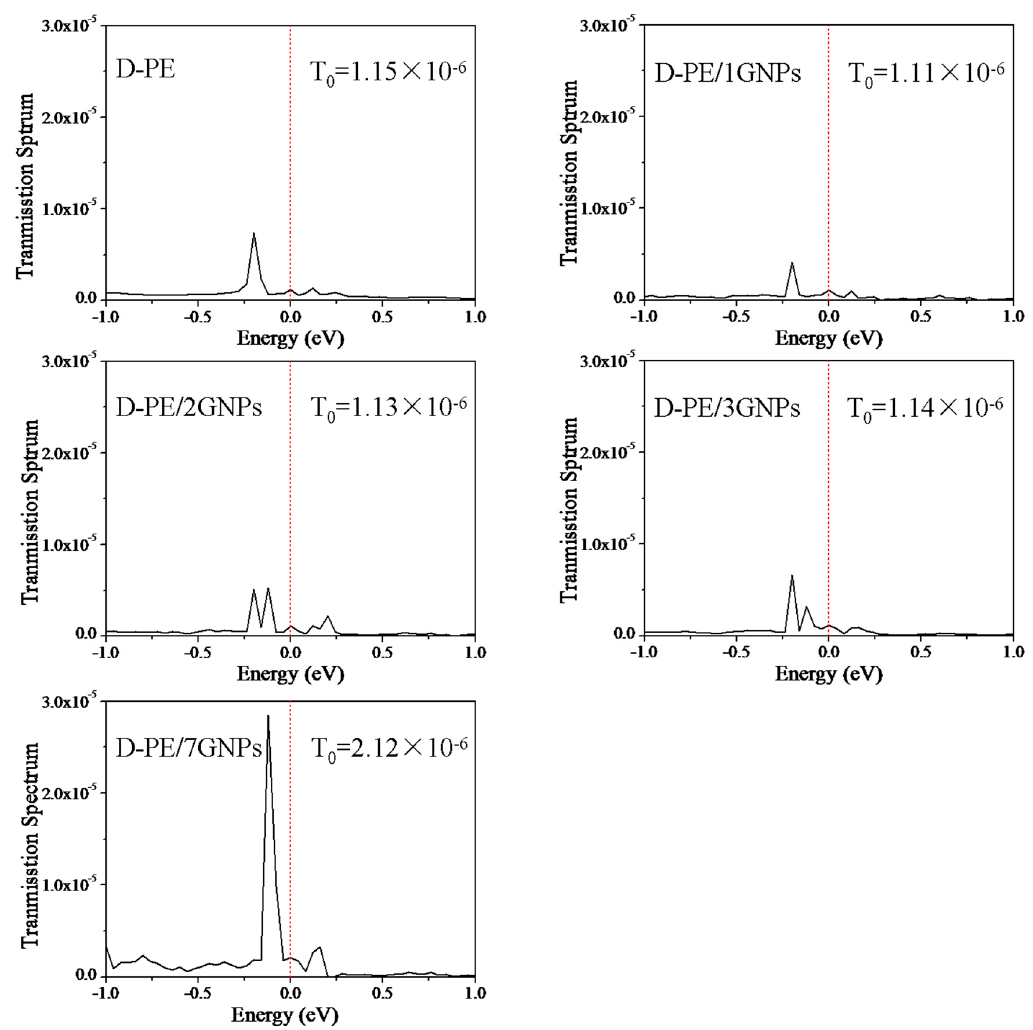
Figure 6. Transmission spectra of D-PE, D-PE/1GNPs, D-PE/2GNPs, D-PE/3GNPs, and D-PE/7GNPs two-probe devices at 0.0 V bias voltages.